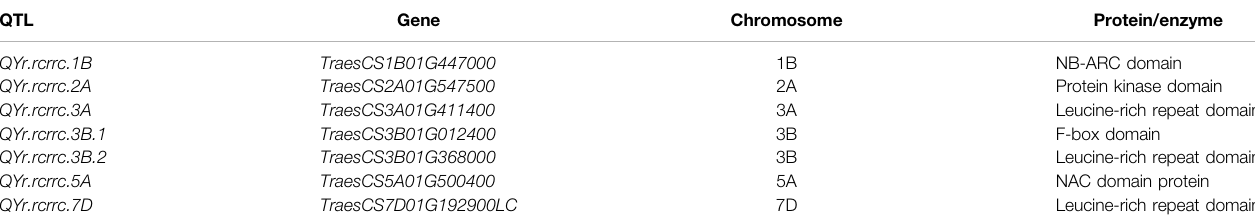
TABLE 5 | List of candidate genes for each QTL with putative proteins/enzymes. QTL